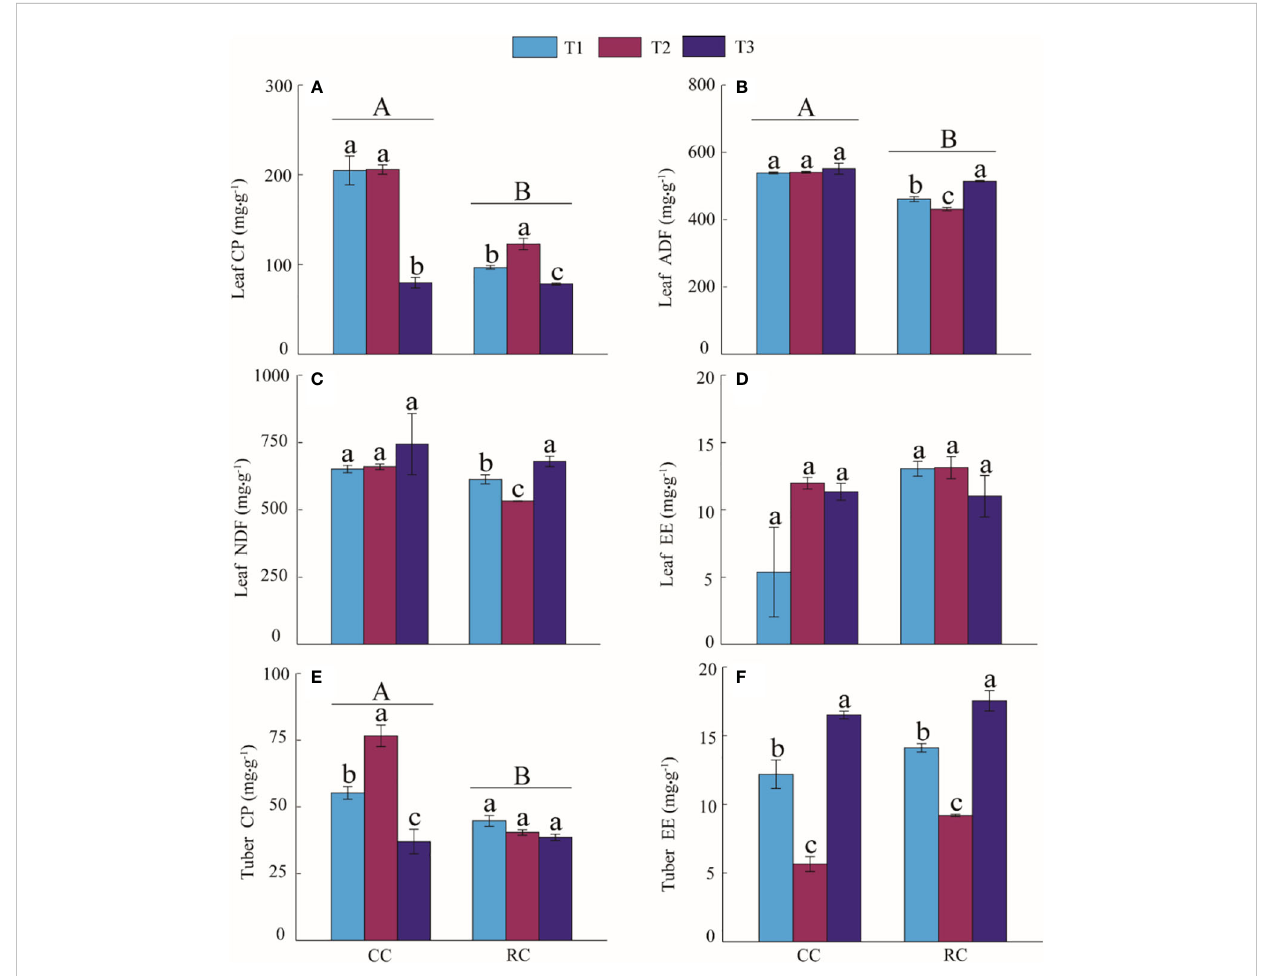
FIGURE 2 Effects of the continuous cropping (CC)/rotation cropping (RC) and mowing time on [ A (crude protein (CP)], B [acid detergent fi ber (ADF)], C [neutral detergent fi ber (NDF)], and D [ether extract (EE)], contents of the leaves and E [crude protein (CP)] and F [ether extract (EE)], contents of the